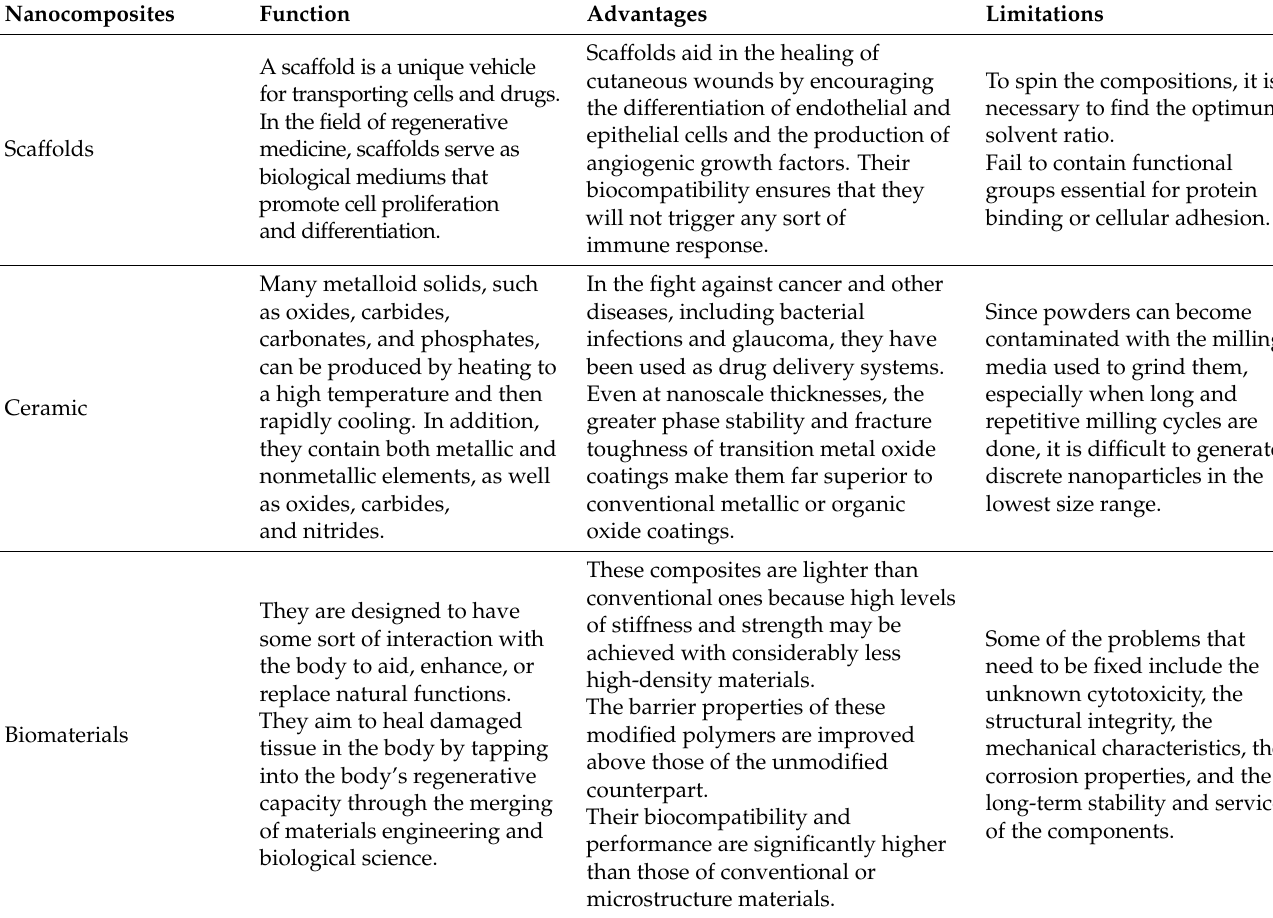
Table 1. The basic principles, advantages, and limitations of different types of nanocomposites for bone